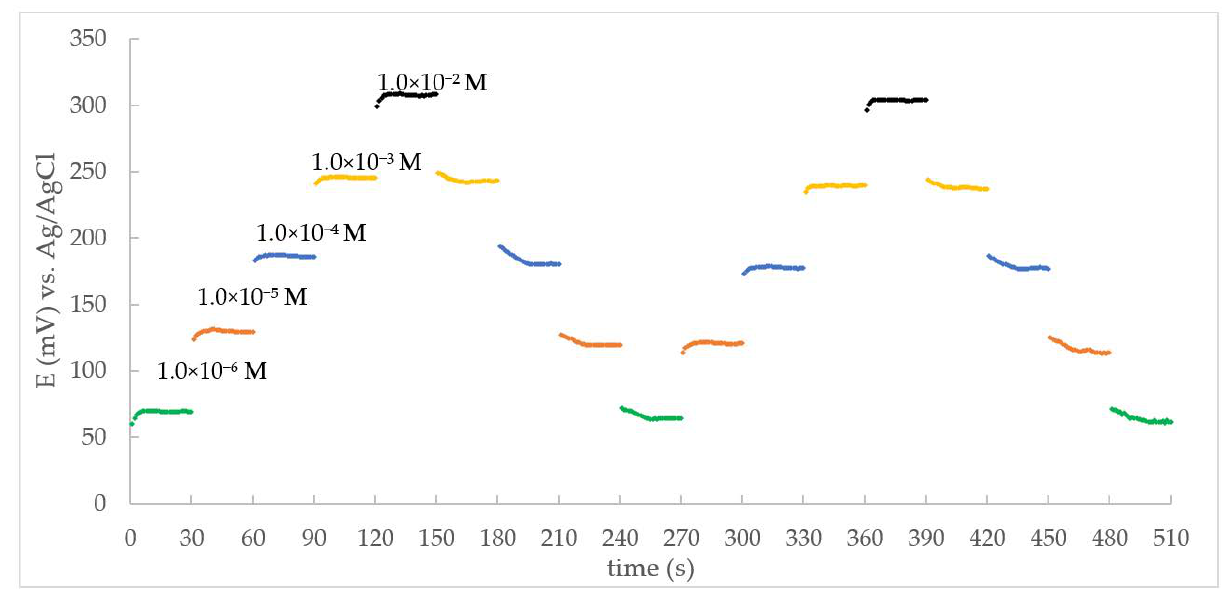
Figure 5. Dynamic response time and reversibility of the proposed